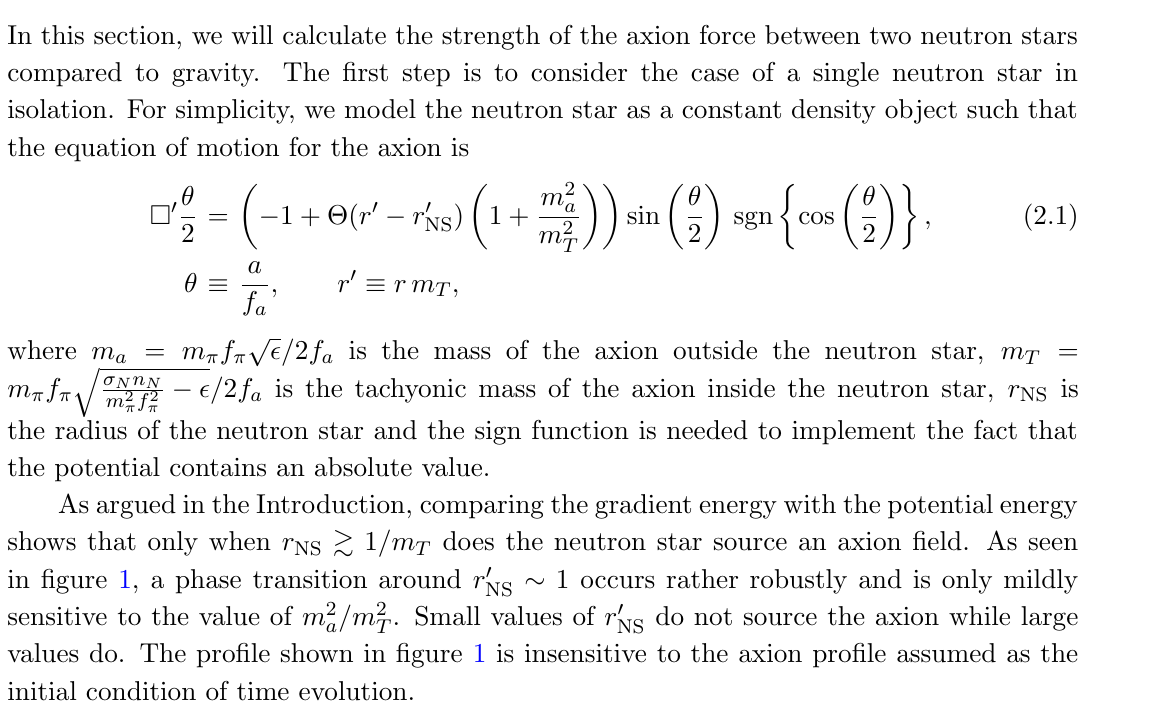
Figure 1 . Value of (cid:18) = a=f a at the center of the neutron star as a function of r 0 curves correspond to m 2 =m 2 = 0.1 (black), 0.01 (blue), 0.001 (purple) and 0 (brown) from right to a T left. An initial pro(cid:12)le was assumed and then time evolved with friction towards the stable solution. The resulting data points were (cid:12)tted to a smooth curve. There is clearly a phase transition where only at a particular radius does the neutron star start to source the